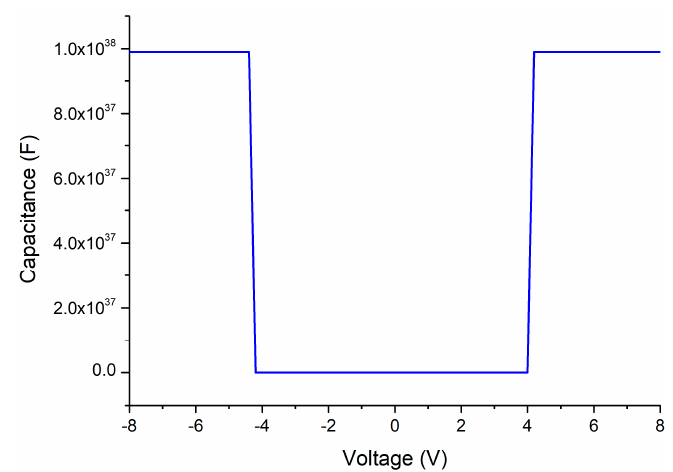
Figure 7. Capacitance–voltage (C–V) measurements of the breakdown MSM varactor.